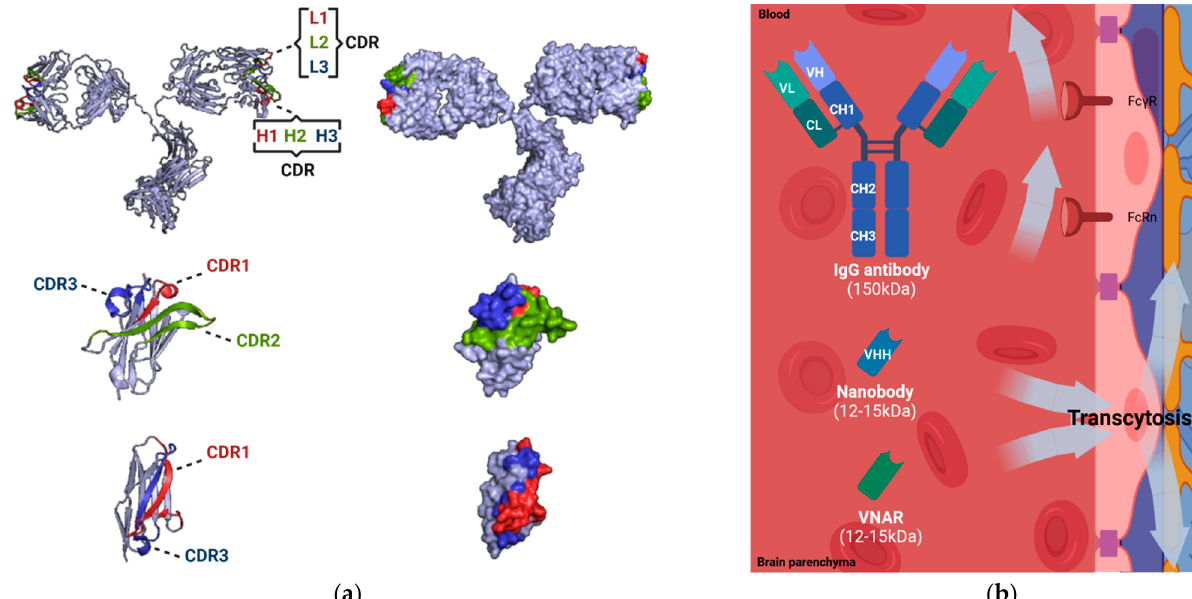
Figure 2. Comparison of IgG antibodies and single-domain antibodies (nanobodies and VNARs). ( a ) Molecular 3D structures of canonical IgG antibody (PDB reference: 1IGT), nanobody (PDB reference: 1I3V), and VNAR (PDB reference: 4HGK). The complementarity determining regions (CDRs), known to be responsible for antigen recognition, are displayed (CDR1, in red; CDR2, in green; CDR3, in blue) [37,38]. ( b ) Delivery of IgG antibodies and single-domain antibodies (nanobodies and VNARs) at the BBB. The permeability of IgG antibodies is limited due to the presence of Fc receptors (Fc γ receptor, Fc γ R; neonatal Fc receptor, FcRn). The permeability of single-domain antibodies (nanobodies and VNARs) is facilitated by physiological transcytosis mechanisms. Image created with PyMOL2 and BioRender.com (accessed on 17 June 2021).